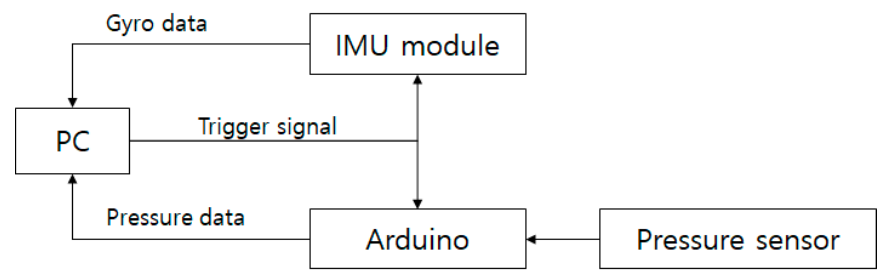
Figure 2. Hardware configuration.